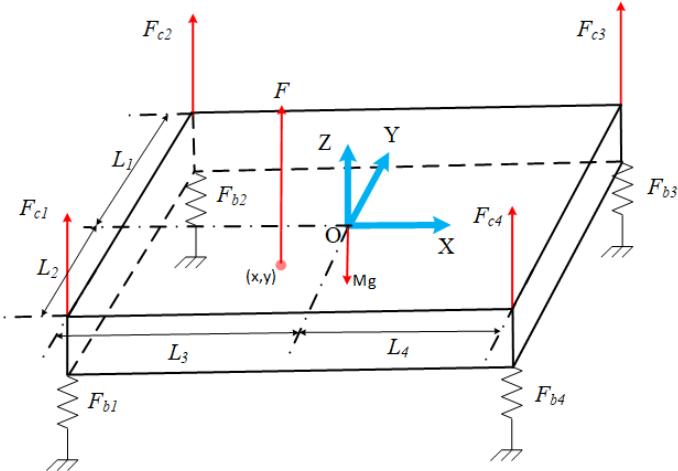
Figure 22. Dynamic